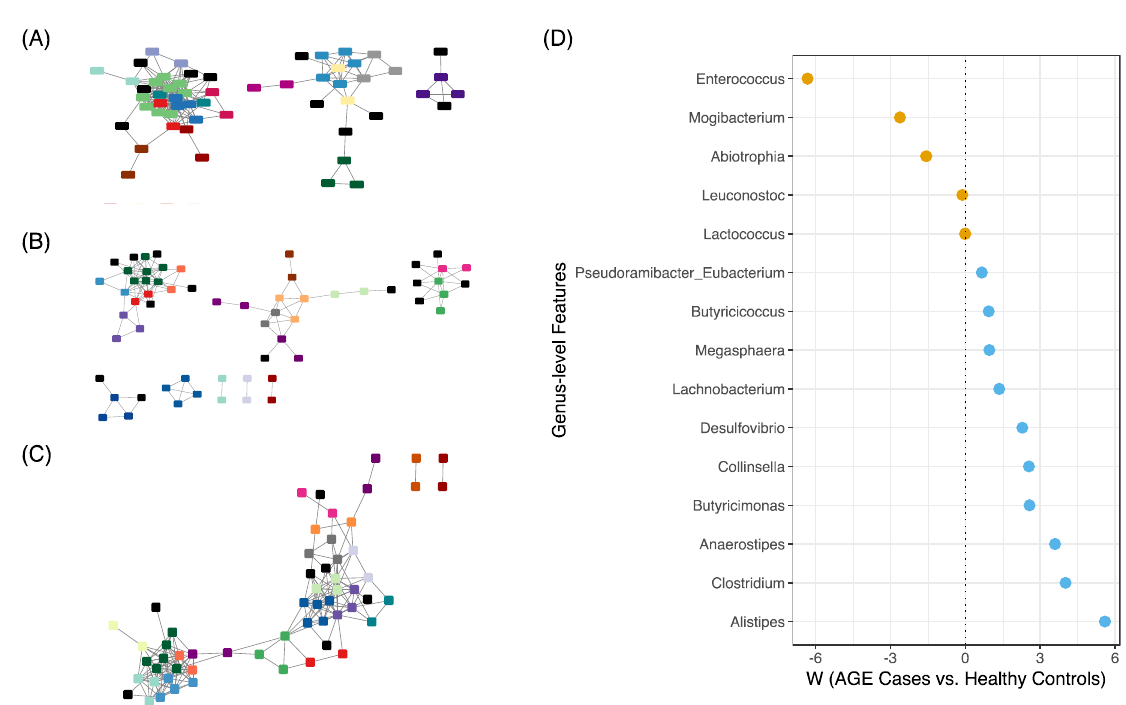
Figure 6. Correlation network analysis of faecal microbiota. Correlation networks for ( A ) All groups, ( B ) AGE cases, and ( C ) Healthy controls. Module memberships identified by SCNIC are shaded with colours other than black (for instance, shared membership under module-0 is shaded light green on panel A). Nodes (with rectangular/square shapes) represent genera, and edges represent correlations with an R-value greater than 0.35. ( D ) Differential abundance testing with ANCOM-BC. Genera that passed multiple test correction (Benjamini and Hochberg’s FDR < 0.05) are shown. Dots with negative W values represent genera enriched in AGE cases, while positive values represent genera enriched in healthy controls.